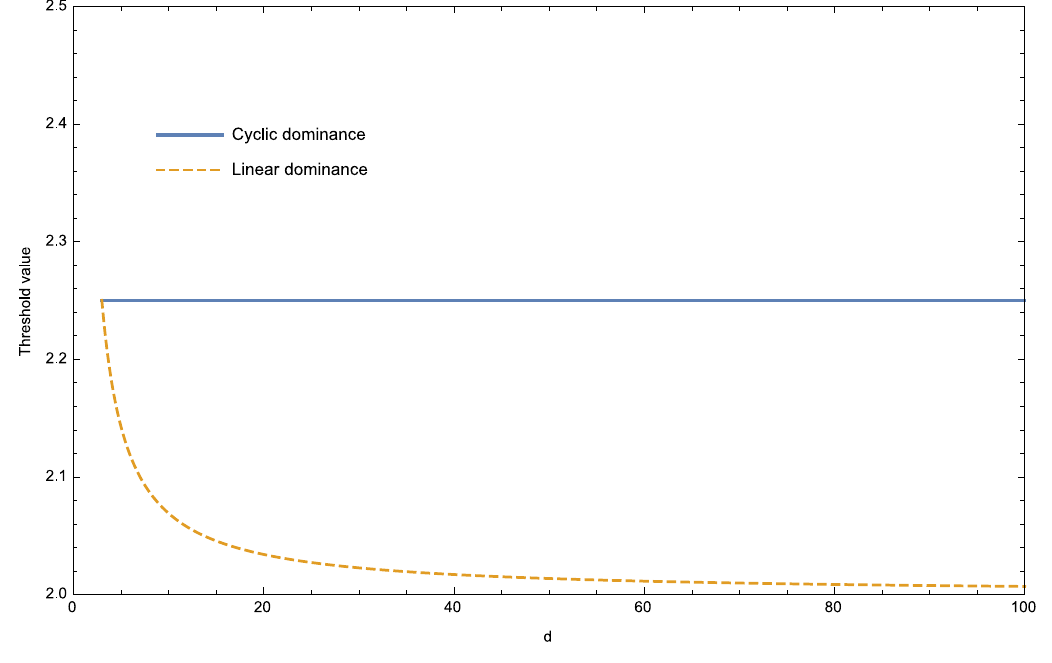
Figure 3. Exact threshold value that R must exceed for cooperation to be favoured by weak selection under linear dominance and cyclic dominance in the N → ∞ limit as a function of the number d of colonies, for b = 2 , c = 1 and β = 1 . The threshold value is the same for d = 3 , since the complete graph coincides with the cyclic graph in this case. However, while this value remains constant in the case of cyclic dominance as d increases, it decreases in the case of linear dominance, making cooperation more